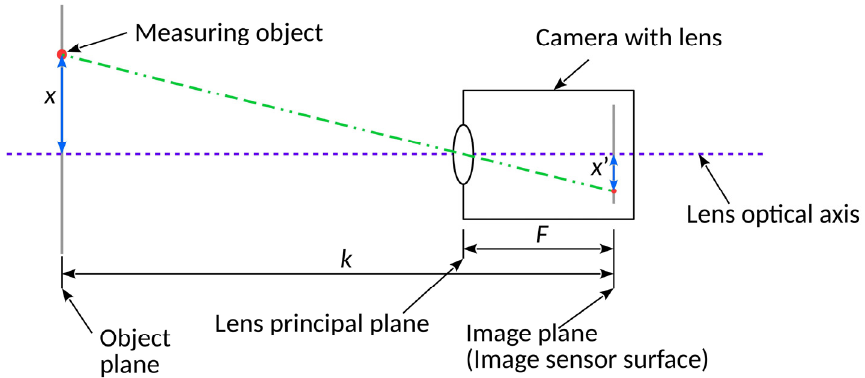
Figure 1. Scheme of the measurement stand (top view): k —distance between the object plane and the image plane (image sensor); F —distance between the plane of the optical centre of the lens and the image plane; x —displacement distance of the object measured in the horizontal axis in relation to the optical axis of the lens; x (cid:48) —location of the image of the object measured in the horizontal axis.